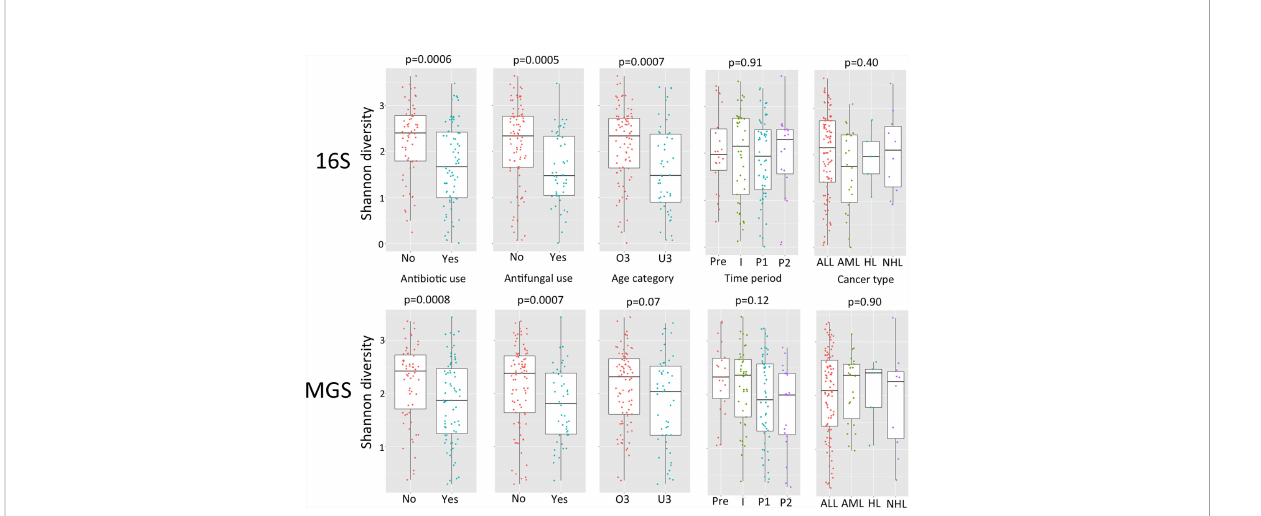
FIGURE 2 Comparison of alpha diversity using Shannon diversity for 16S rRNA gene (16S) and whole shotgun metagenome data (MGS) for antibiotic use, antifungal use, age category (O3, over 3 years of age; U3, under 3 years of age), time period of treatment (Pre, pre-chemotherapy days -5 to 0; I, induction days 1 to 30; P1, post induction days 31 to 180; P2 post induction days 181+), cancer type (ALL, acute lymphoblastic leukemia; AML, acute myeloid leukemia; HL, hodgkin ’ s lymphoma; NHL, non-hodgkin ’ s lymphoma). P values are calculated using Wilcoxon test for pairwise and Kruskall-Wallis for multiple comparisons.